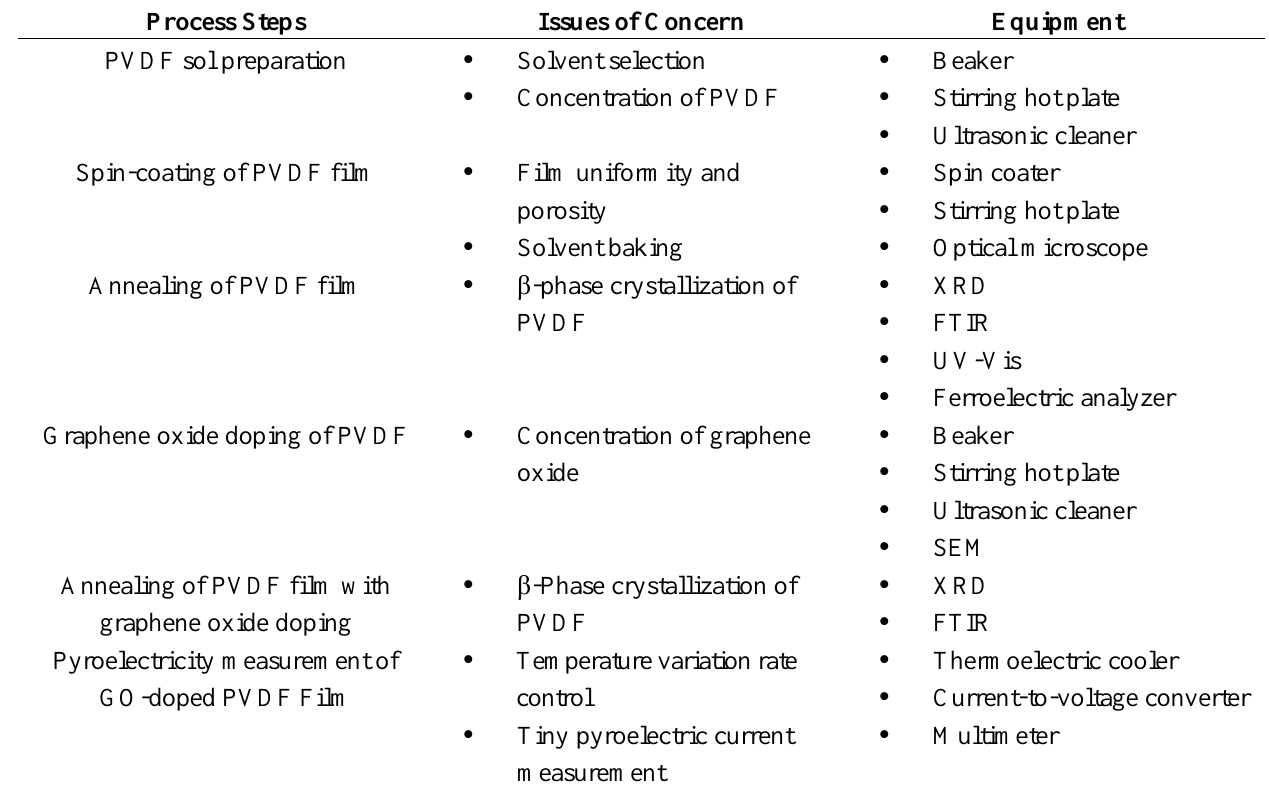
Table 1. The recipes for GO-doping